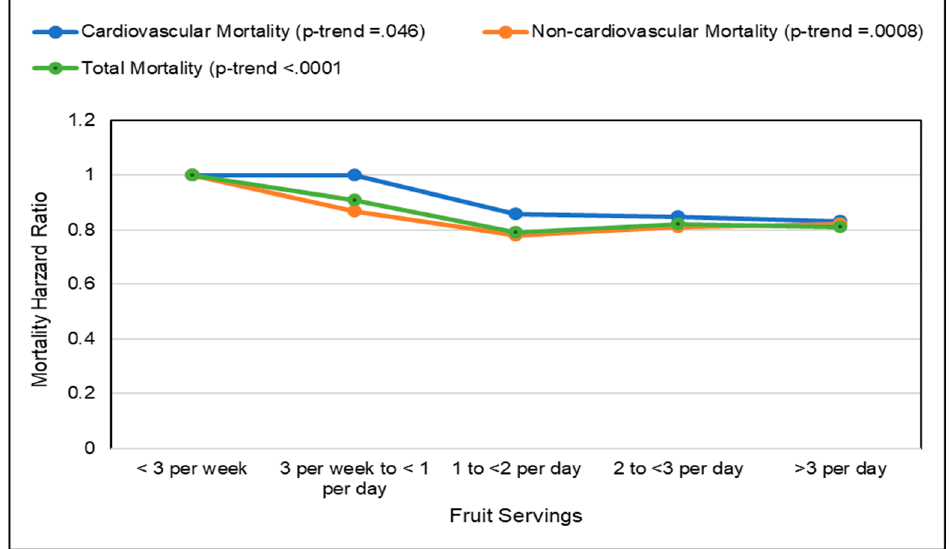
Figure 21. Association of fruit intake with mortality risk for a composite of European, American, Japanese and Chinese adults (mean age 50 years over 7.4 years; multivariate adjusted) [4].